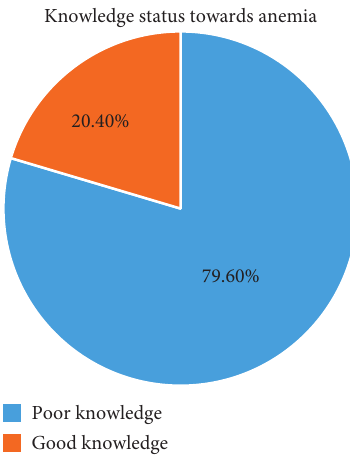
Figure 2: Knowledge status towards anemia among secondary school adolescent girls in Jimma